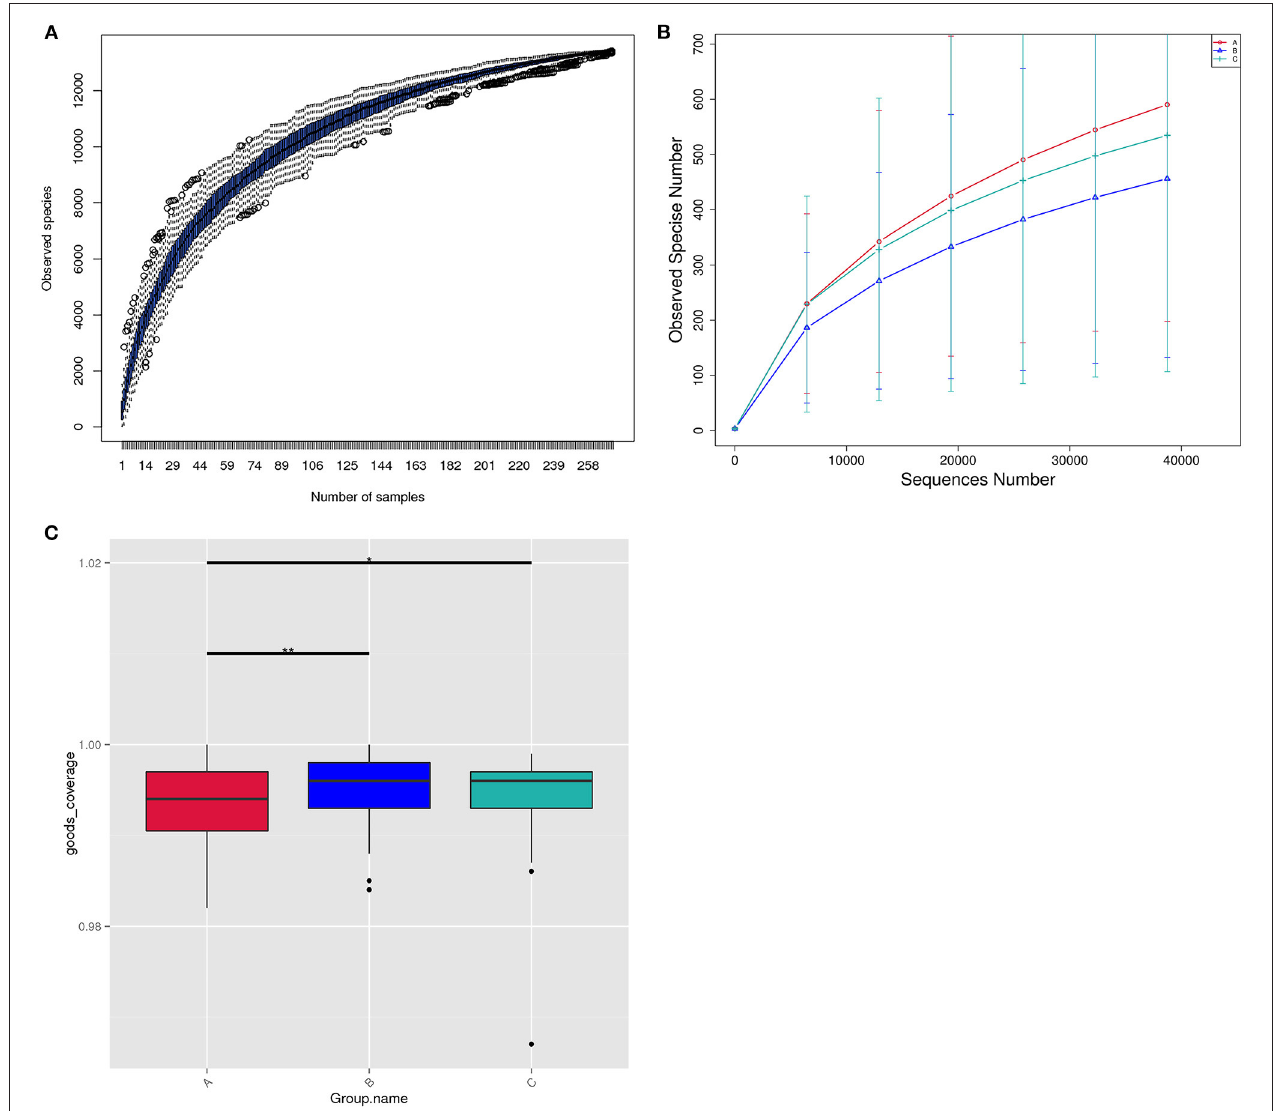
FIGURE 3 | The structure of the vaginal microbiome within three groups. (A) Species accumulation boxplot of all the 272 samples in three groups. (B) Rarefaction curve of vaginal microbiome diversity in three groups, and error bars represent standard deviation. Alpha diversity analyses revealed Observed Species differences within three groups. (C) Bar chart of microbiota diversity for each